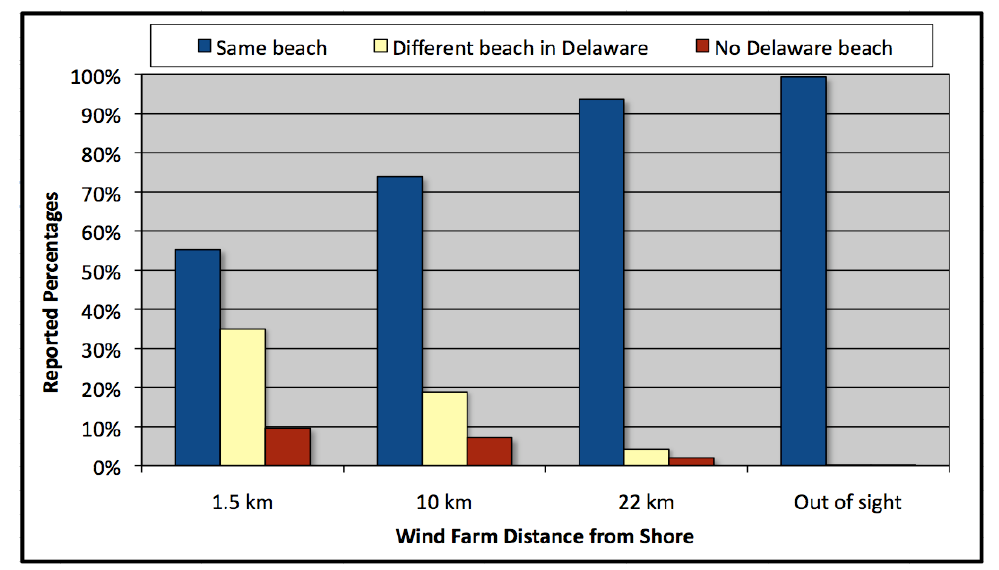
Figure 1. Reported visitation at varying wind farm distances (n =